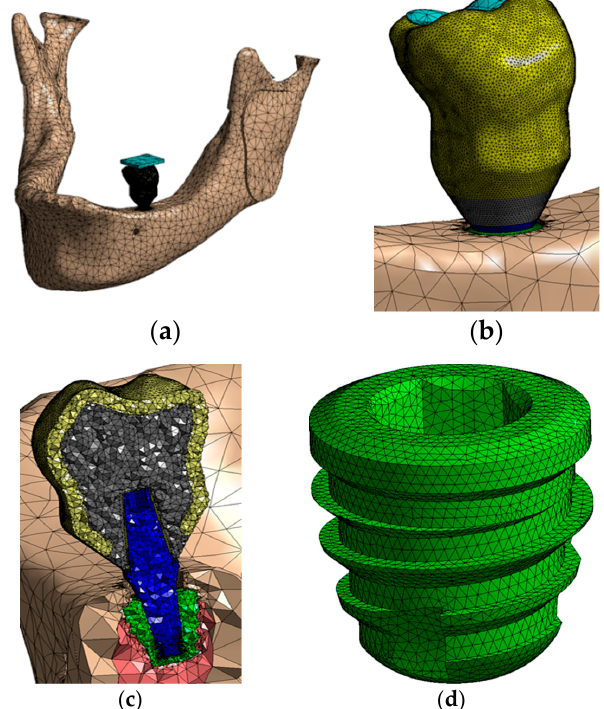
Figure 7. Mesh generated: ( a ) Whole assembly; ( b ) a view of the crown; ( c ) a transversal cut of the model; ( d ) IH implant.